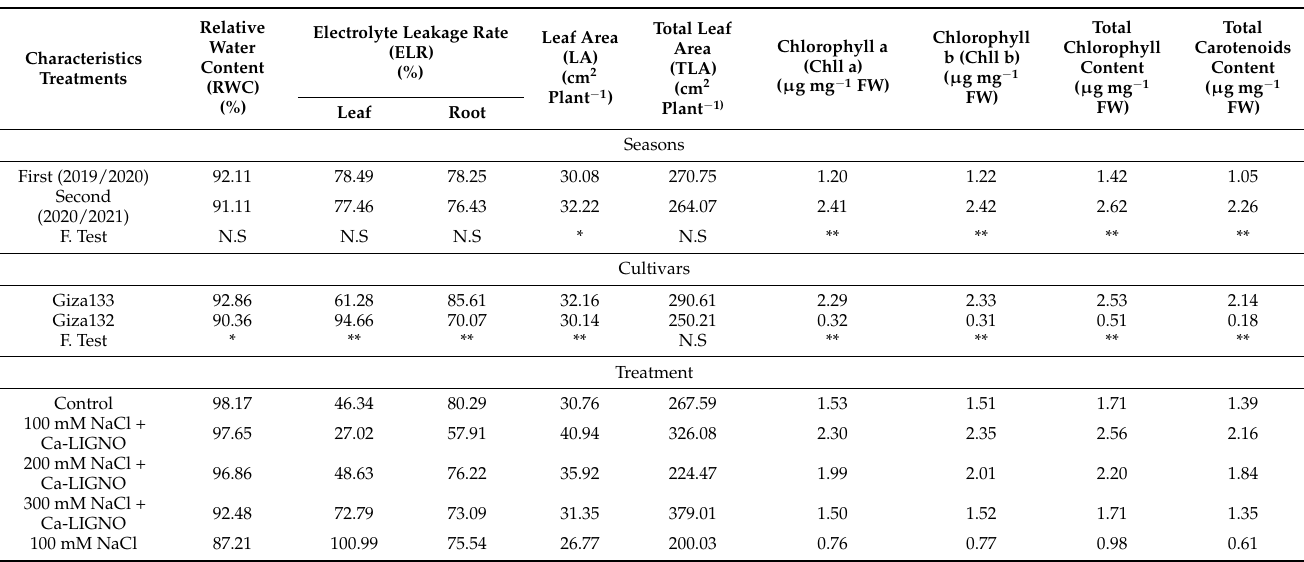
Table 3. Means of relative water content (RWC), leaf and root electrolyte leakage rate (ELR), leaf area (LA), and total leaf area (TLA), and different pigments concentrations (chlorophyll a, chlorophyll b, total chlorophyll, and total carotenoids) in the leaves of Giza133 and Giza132 barley cultivars under different treatments (control, NaCl concentrations, and NaCl concentrations + Ca-LIGNO) during two seasons, 2019/2020 and